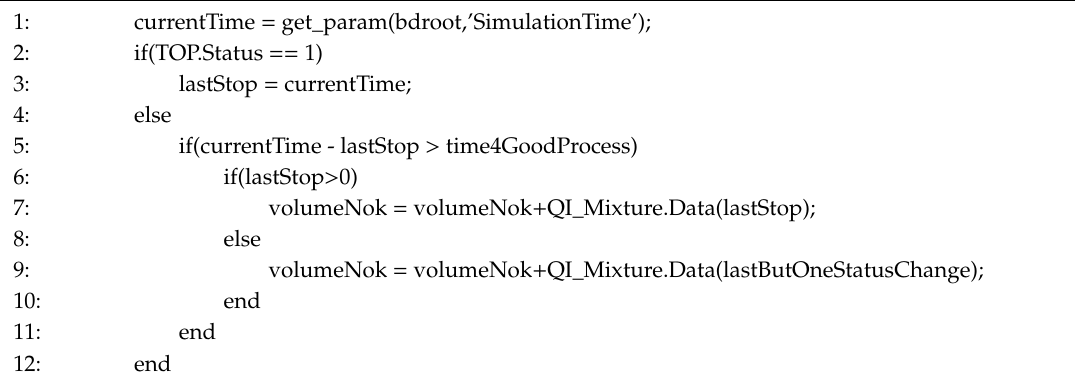
Algorithm 3. Code for the definition of the quality requirement of the case